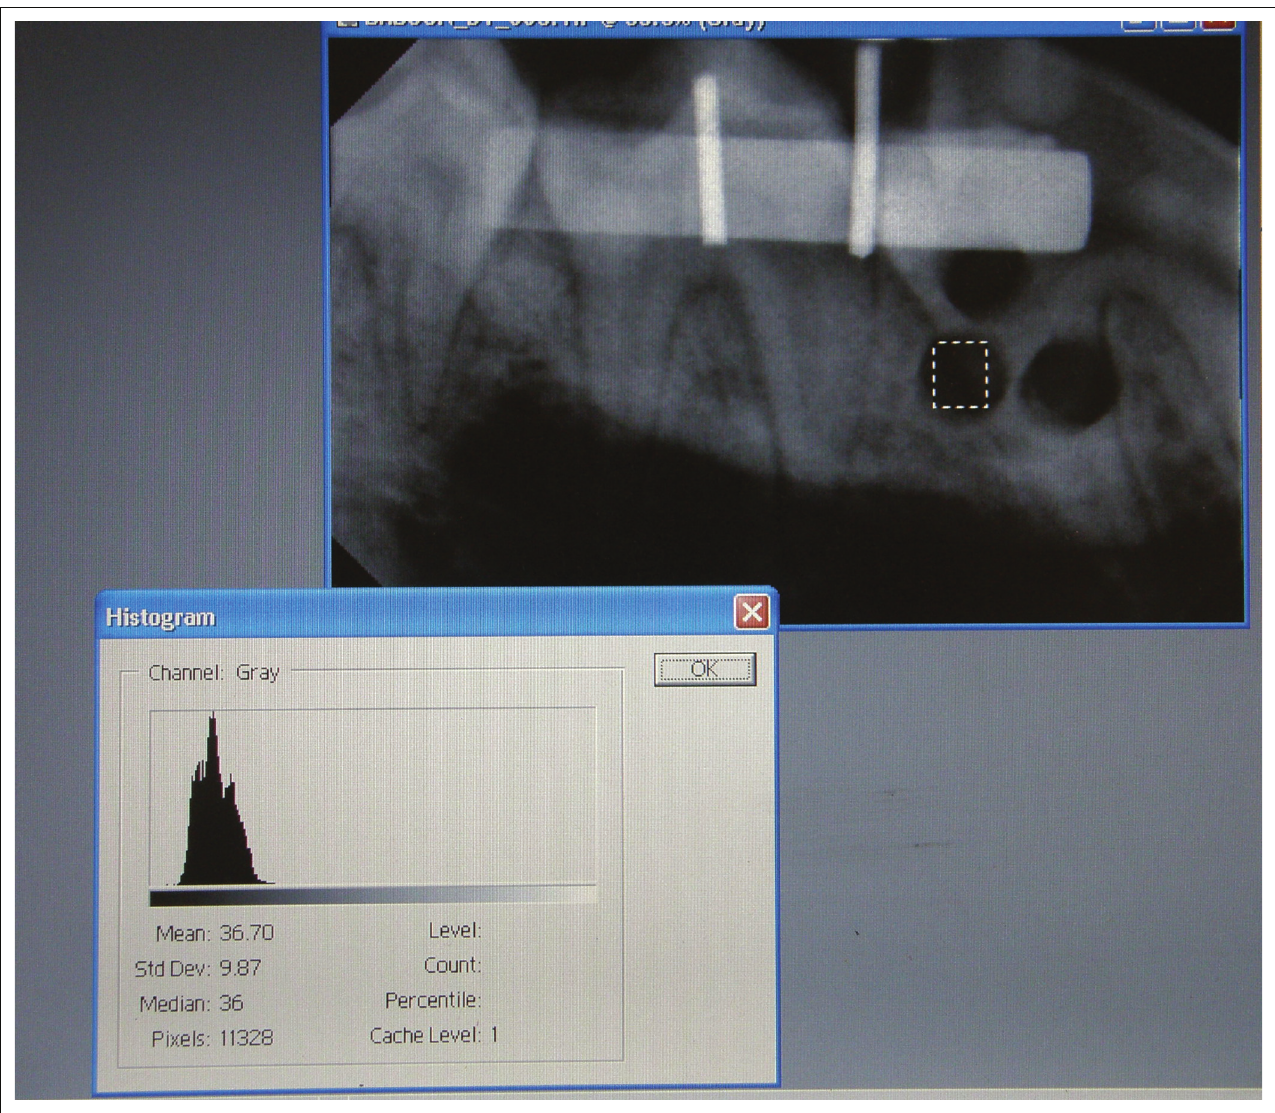
Source : Kotze, M.J., Bütow, K.-W. & Kotze, H.F., 2012, ‘A radiological method to evaluate alveolar bone regeneration in the Chacma baboon (Papio ursinus)’, South African Dental Journal 67, 210–214 FIGURE 4: An image of the computer screen displaying the histogram and reflecting the average radiographic intensity of the image of the selected area of the created